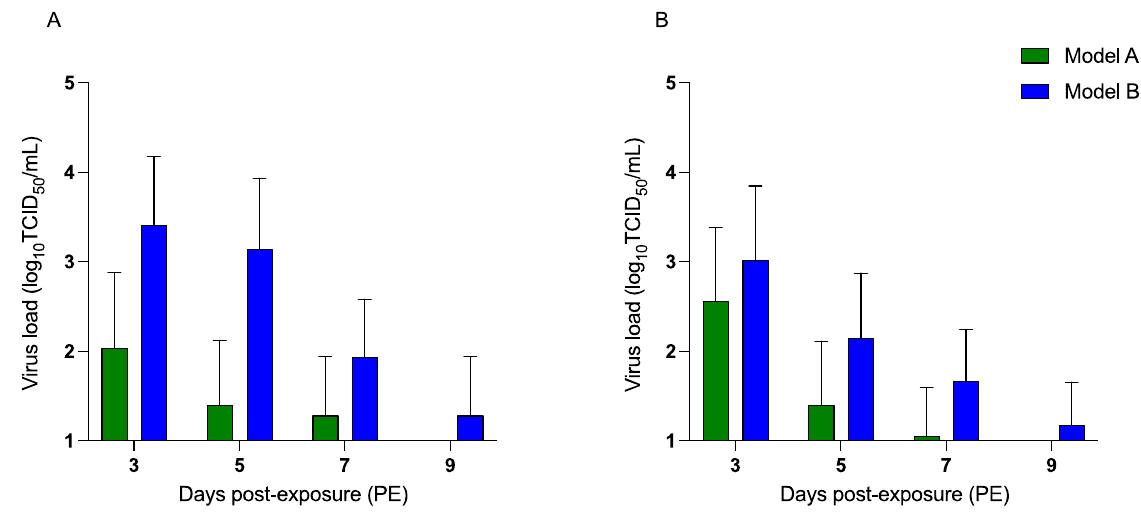
Figure 4. H9N2 AIV shedding in the oral and cloacal swabs on days 3-, 5-, 7- and 9 PE in the exposed chickens. Mean H9N2 AIV titers (TCID 50 /mL) in the oral ( A ) and cloacal ( B ) swabs were determined in the exposed chickens ( n = 10) post-exposure (PE) in models A and B. In model A, H9N2-inoculated chickens (seeder group) were replaced with healthy exposed chickens on day 3 PI and H9N2 AIV shedding was assessed on days 3-, 5-, 7- and 9 PE. In model B, naïve chickens were added immediately after the dissemination of the H9N2 AIV-spiked fecal inoculum. Virus load (log 10 transformed) in the exposed chickens was assessed based on TCID 50 assay at the above-mentioned time points.